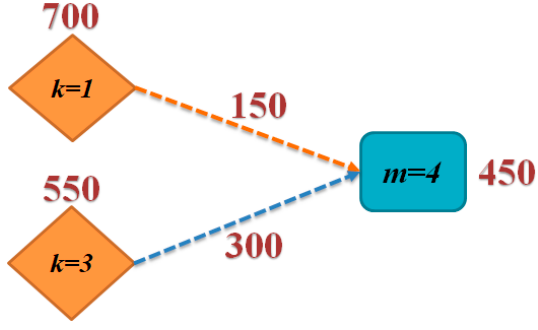
Figure 4. Demand satisfaction for consumer zone 4.